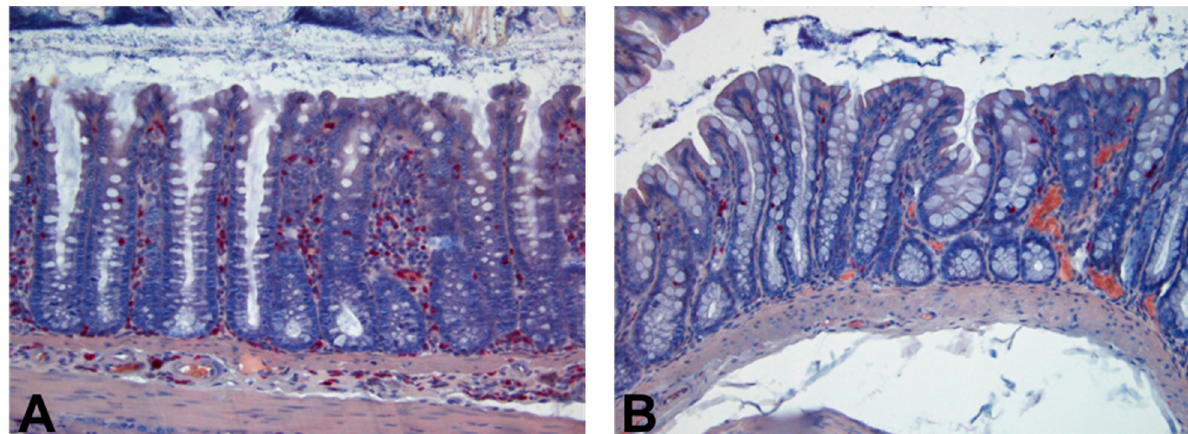
Figure 4. Histopathological changes in the colon from rats infected with C. difficile 10 days post-infection ( A ) with no treatment and ( B ) treated with xanthohumol. Tissue samples are stained with a naphthol AS-D chloroacetate kit and counterstained with hematoxylin (200-fold original magnification). C. difficile infection leads to high neutrophil infiltration (red color) and edema ( A ), which is substantially reduced by the xanthohumol treatment ( B ).